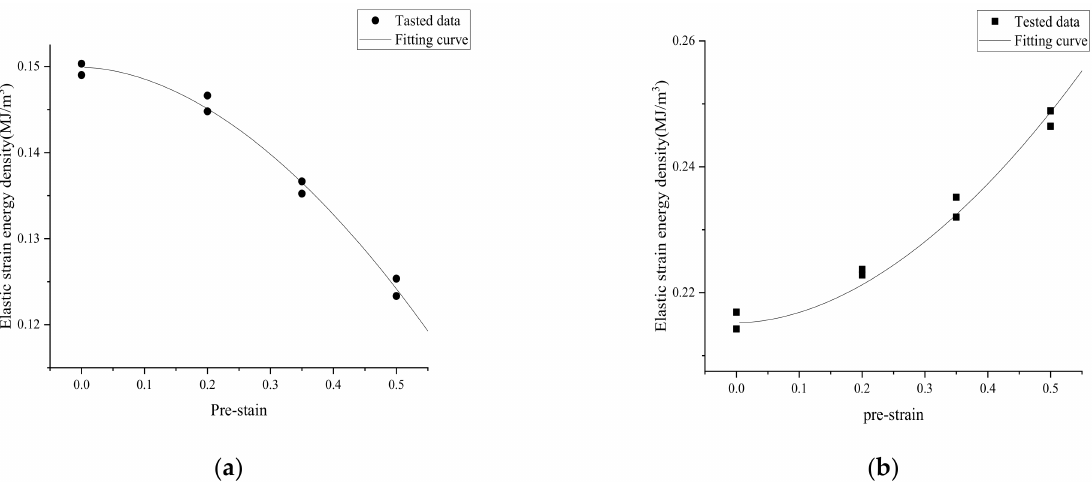
Figure 10. Relationship strain energy density and pre-strain at 0.15% strain amplitude. ( a ) Elastic strain energy density and pre-strain; ( b ) Plastic strain energy density and